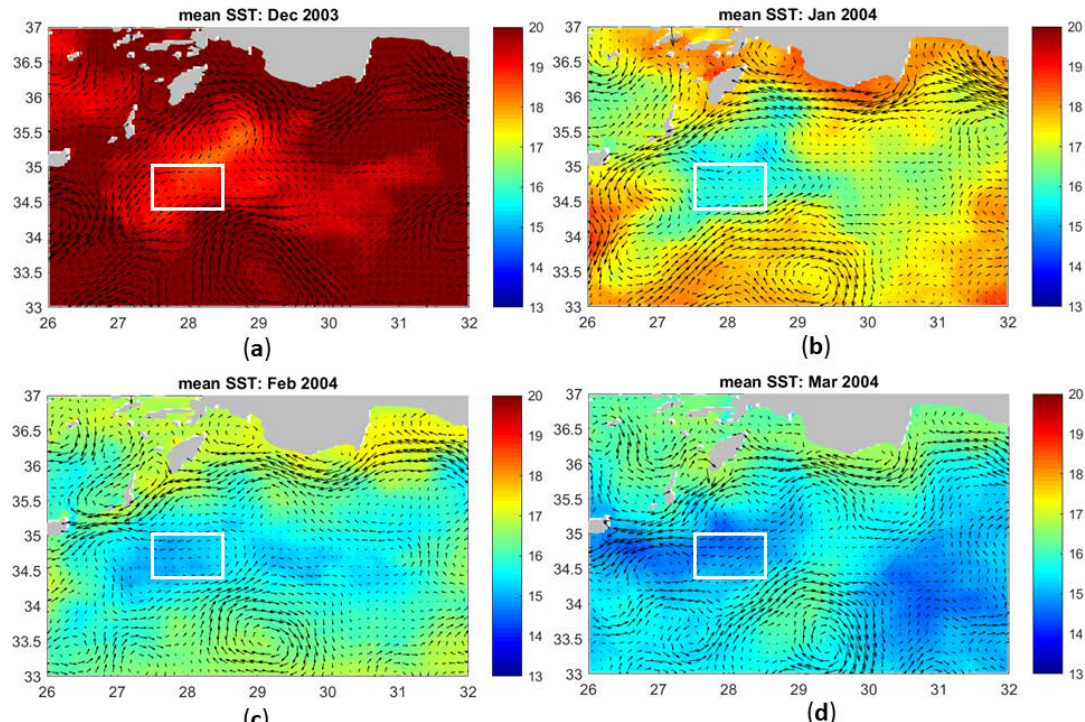
Figure 16. Monthly means of the satellite SST (°C) and absolute geostrophic currents from December 2003 to March 2004. The deep convection event occurred by the end of February and beginning of March 2004 when SST was lowest. The white rectangle shows the position of float WMO 6900098 during JFM 2004.